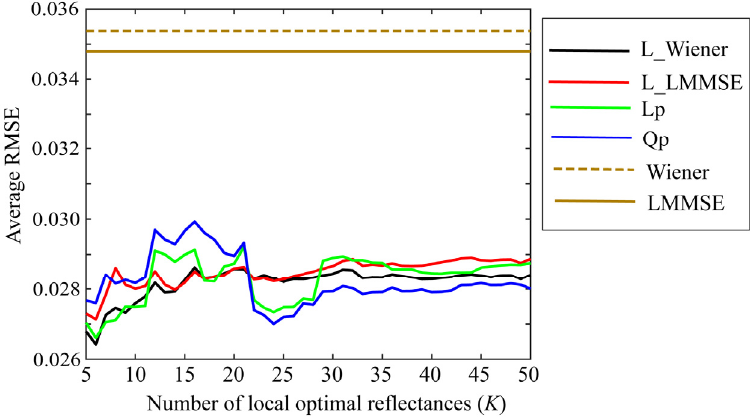
Figure 7. Average RMSEs obtained by the proposed methods for 24 color checkers in the range of small K of 5–50 when applying the methods to image data acquired using Apple iPhone 6s.